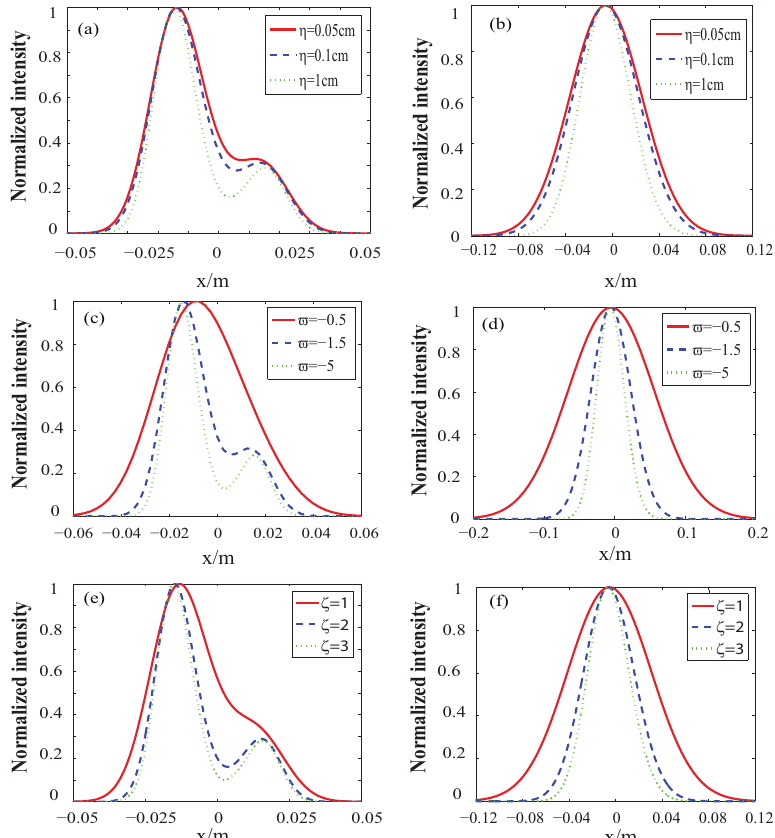
Figure 7. Cross lines ( y = 0) of the normalized average intensity of the OAHGSM vortex beam passing through anisotropic oceanic turbulence with different η , (cid:118) , and ζ at z = 300 m ( a ), z = 800 m ( b ), z = 300 m ( c ), z = 800 m ( d ), z = 300 m ( e ), and z = 800 m ( f ).